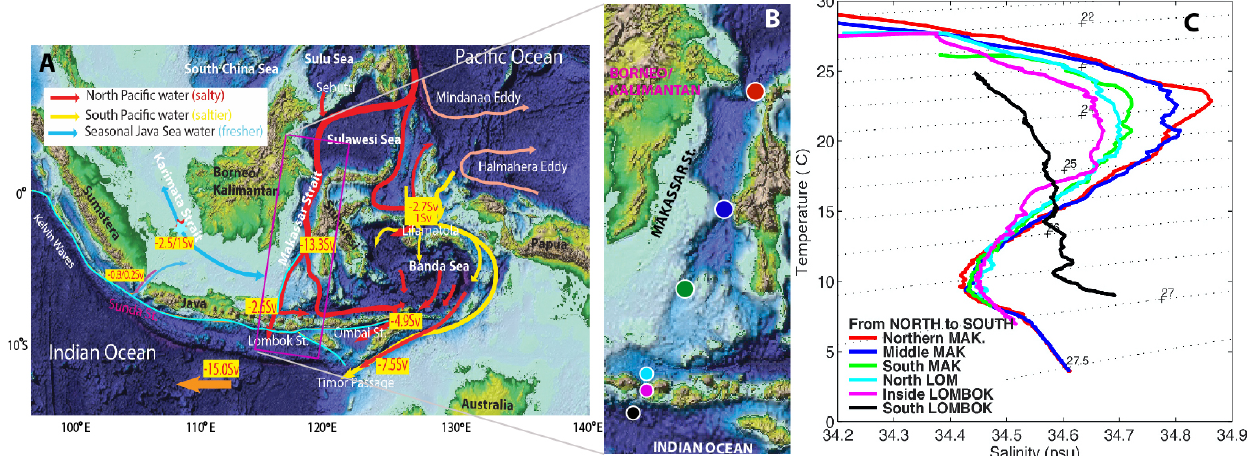
Figure 5. ( A ) Map of the main ITF pathways from the Pacific to Indian Oceans (adopted from Susanto et al. [42]). Numbers denote annual mean ITF transports in each strait with negative values representing transport toward the Indian Ocean; ( B ) Map of the Makassar and Lombok Straits showing the location of the stations used in ( C ); ( C ) TS diagram of the evolution of water masses from north of Makassar Strait through Lombok Strait into the Indian Ocean taken during the Indonesian throughflow monitoring program, revealing vigorous mixing in Makassar and Lombok Straits for potential densities σ θ = 23–27 kg m –3 .